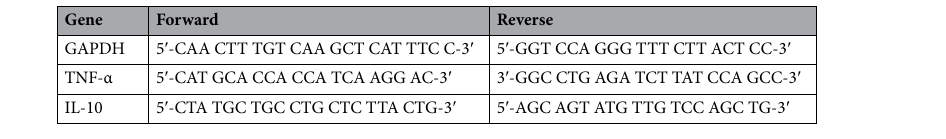
Table 3. PCR primer